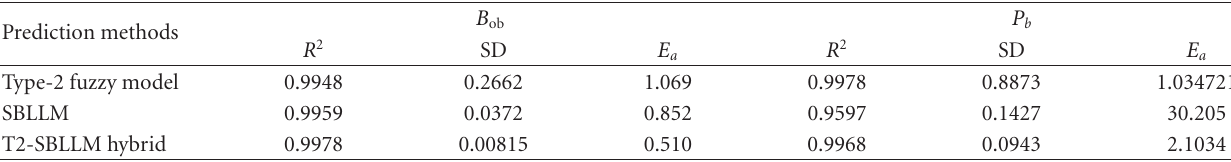
Table 2: Testing results for 283-dataset when predicting B ob and P b . R 2 : correlation coe ffi cient, SD: standard deviation, E a : average absolute